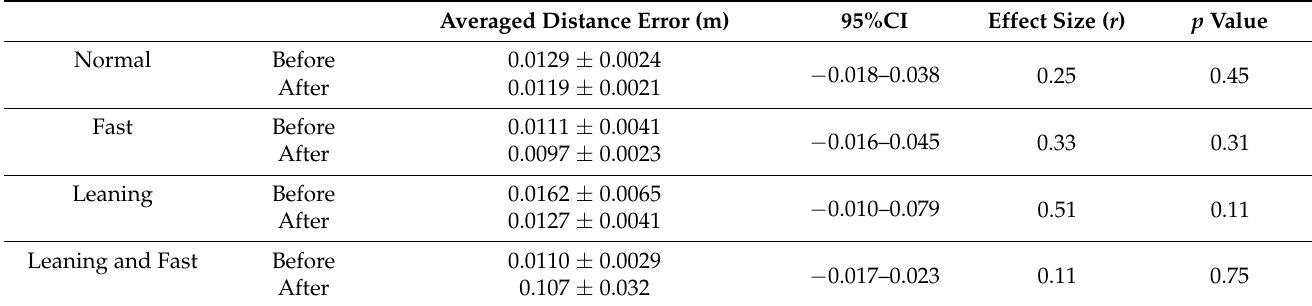
Table 3. Average distance error in the ATG for heel in anterior